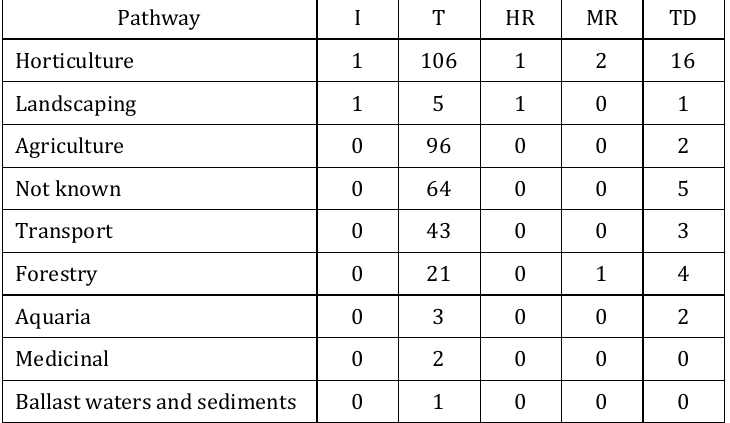
Table 5. Relative significance of pathways based on the following indicators: I- number of invasive species introduced through the pathway, T – total number of non-native species, HR – number of high risk species, MR – number of medium risk species, TD – temporal development ( δ 10 value calculated for the year